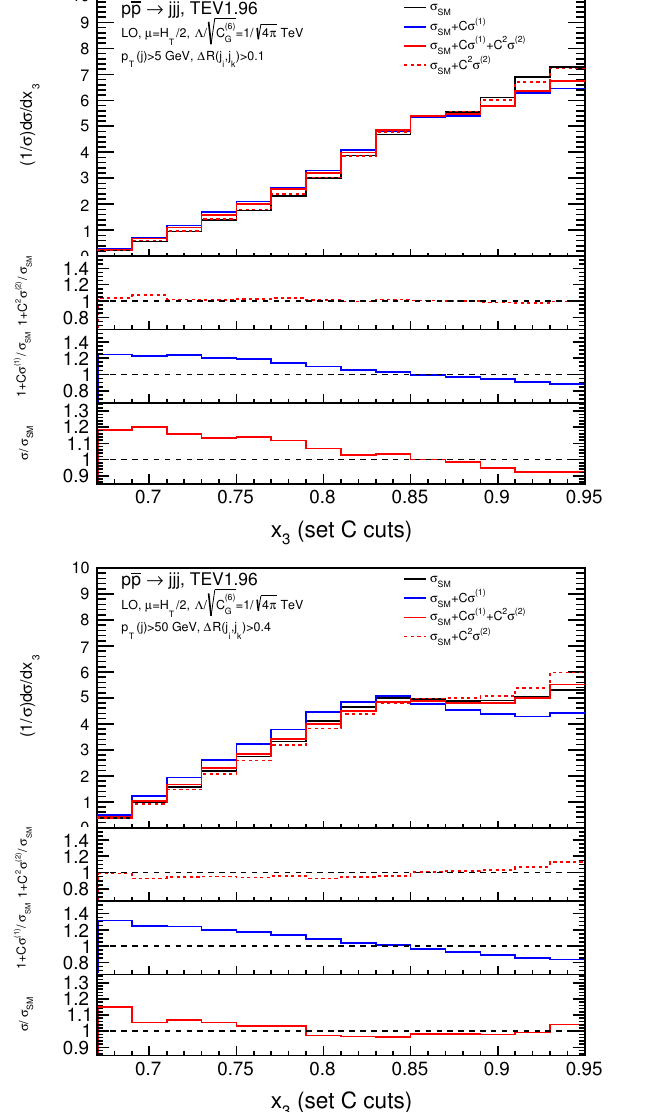
Figure 14 . Distribution of x 3 in three-jet production with the cuts de(cid:12)ned in eq. (3.2). Additional cuts of p T ( j ) > 5 GeV and (cid:1) R > 0 : 1 are applied in the case of the upper plot, while for the lower plot the more realistic cuts of p T ( j ) > 50 GeV and (cid:1) R > 0 : 4 are